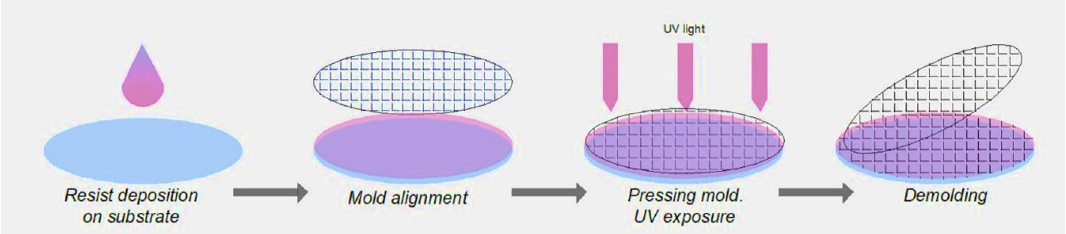
Figure 1. Schematic representation of UV-NIL process (P.46.0.0 AutoCad 2019, https:// www. autod esk. com/ produ cts/ autoc ad/ overv iew? term=1- YEAR& suppo rt=